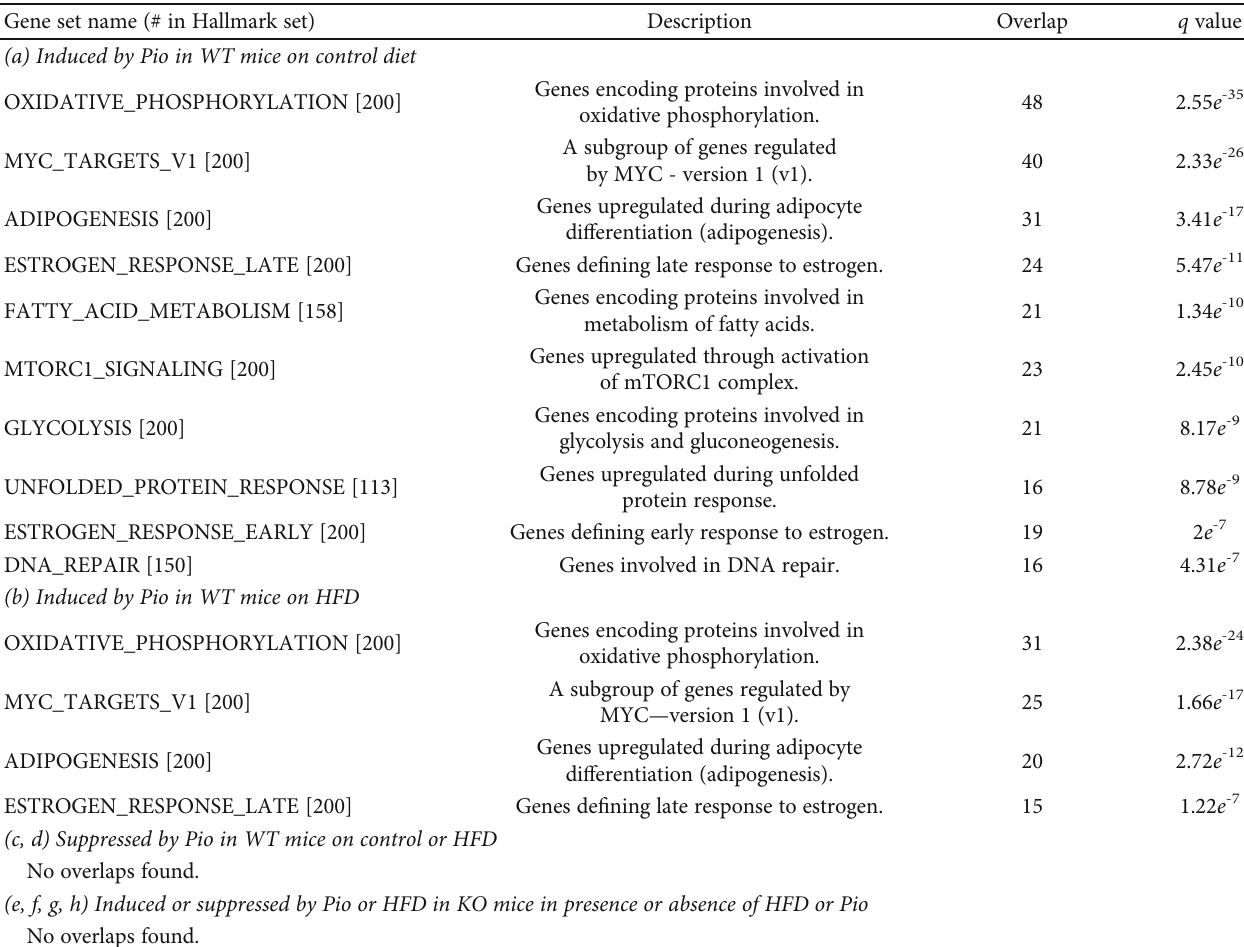
Table 3: Gene set analysis ∗ on RXR ChIP-Seq data from Pio-treated vs. Pio-untreated WT or KO mice on control or HFD (as designated). Gene set name (# in Hallmark